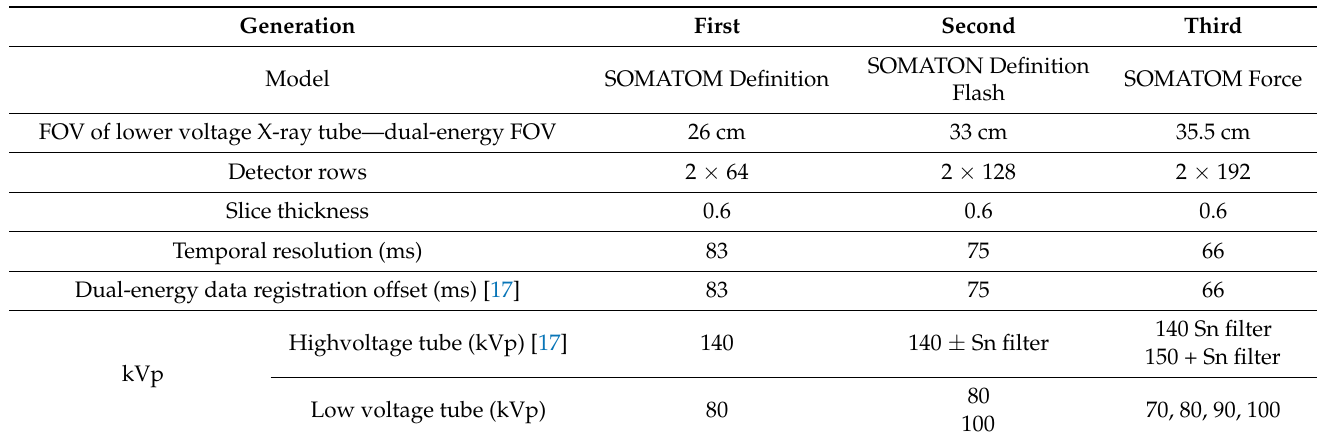
Table 2. The latest generation of dual-source scanners offers best temporal resolution with greater dual-energy FOV and longer Z -axis coverage. The energy separation was also increased which reduce energy overlapping